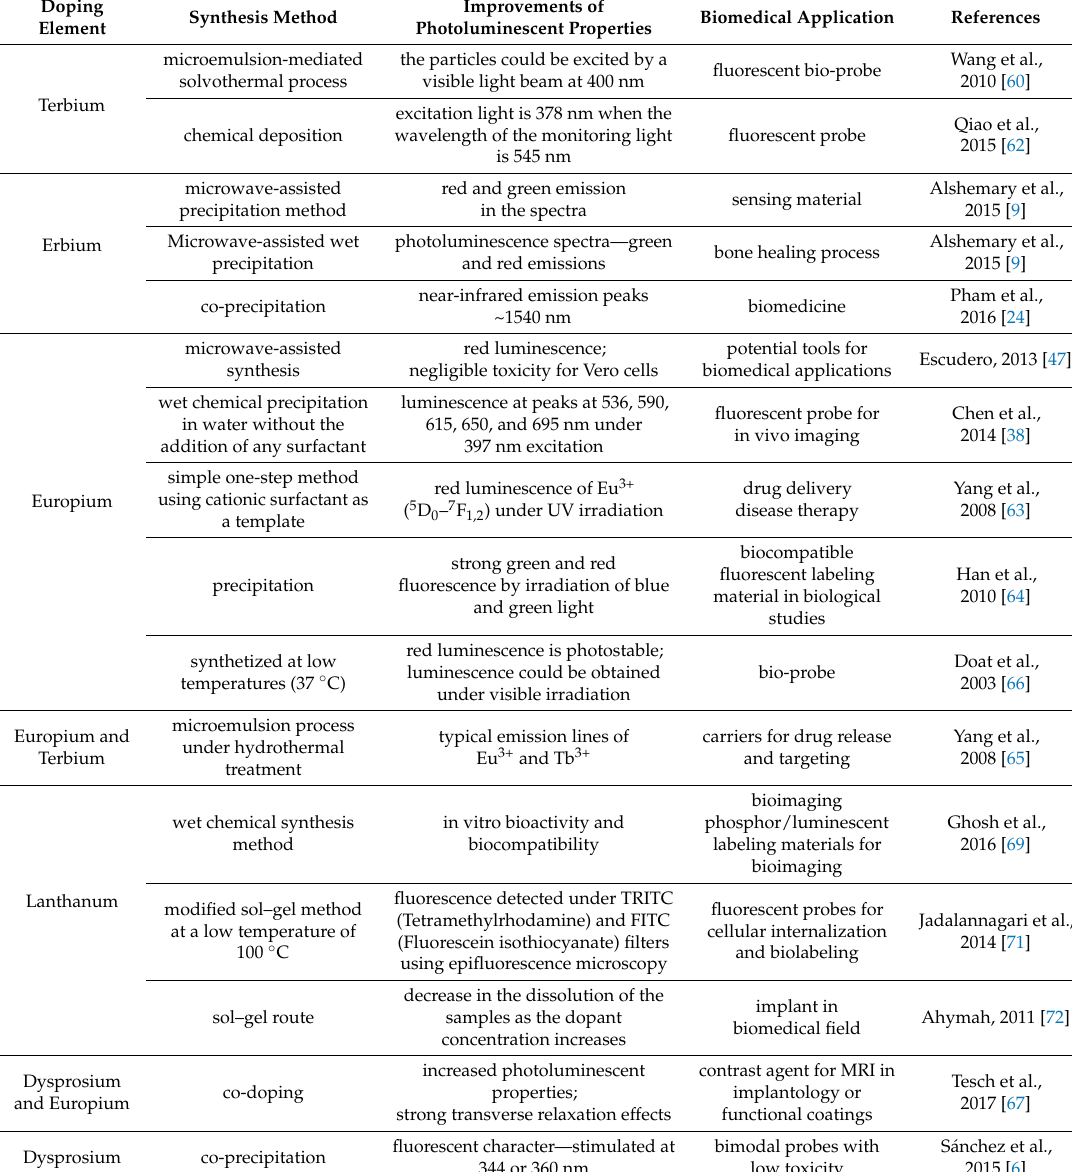
Table 3. Influence of different doping elements on HA properties and the biomedical